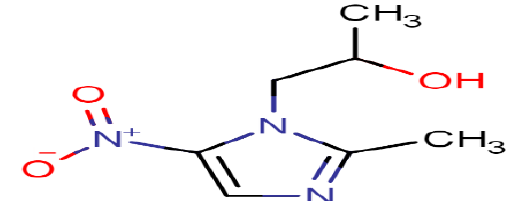
Figure 1. Chemical structures of secnidazole (15)